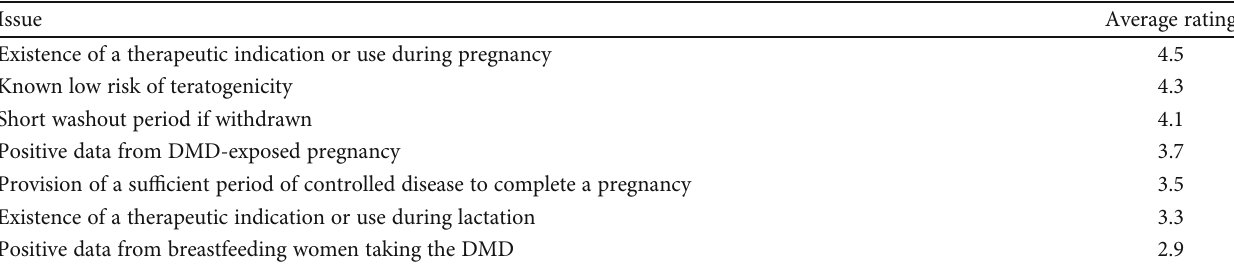
Table 3: Authors ’ rating of issues relevant to the therapeutic use of a DMD in women of childbearing potential.